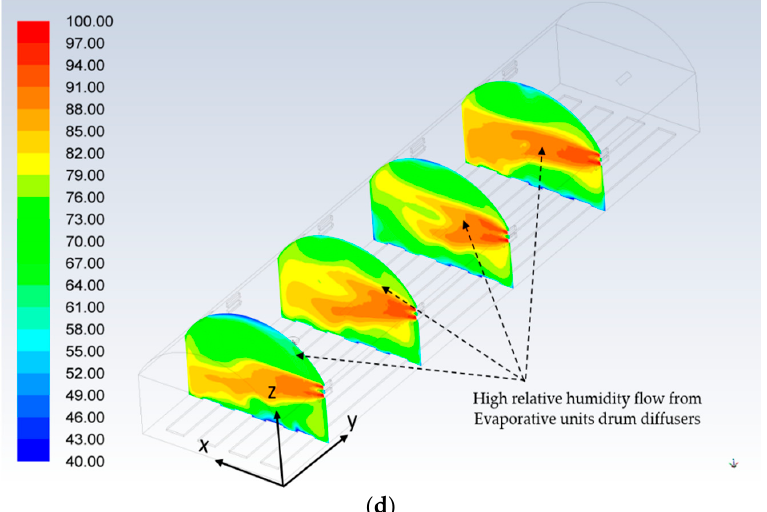
Figure 9. ( a ) Contour plot of relative humidity at a height of 1 m (XY plane). ( b ) Contour plot of relative humidity at a height of 1.7 m (XY plane). ( c ) Contour plot of relative humidity on (YZ plane) along the length. ( d ) Contour plot of relative humidity along XY plane along length of green house at different evaporative cooler locations on one side wall.